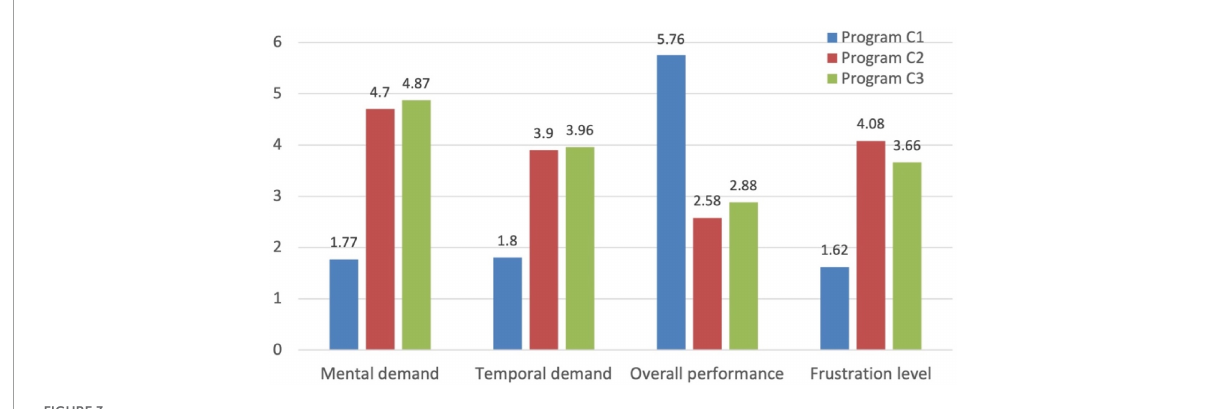
FIGURE3 NASA-TLX average results considering all